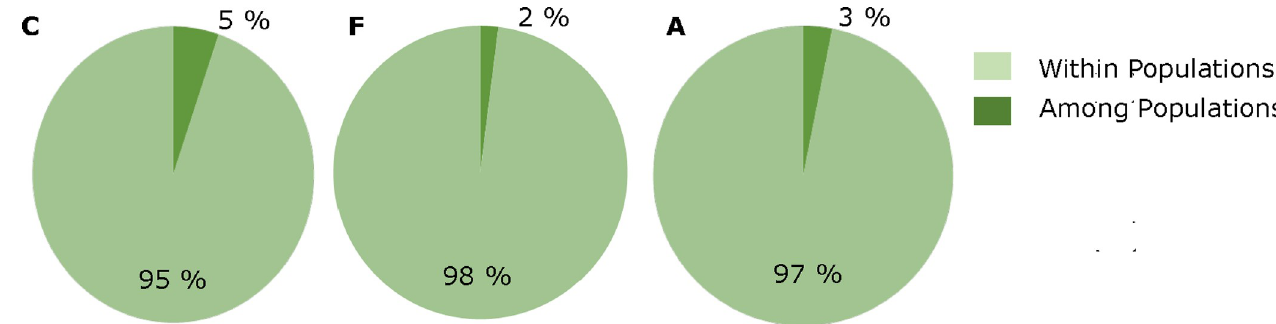
Fig 5. AMOVA results based on 999 permutations for data sets C and F and groups NORTH, SOUTH and GER (G) using the 12 nuclear SSR marker genotypes transformed into binary data.